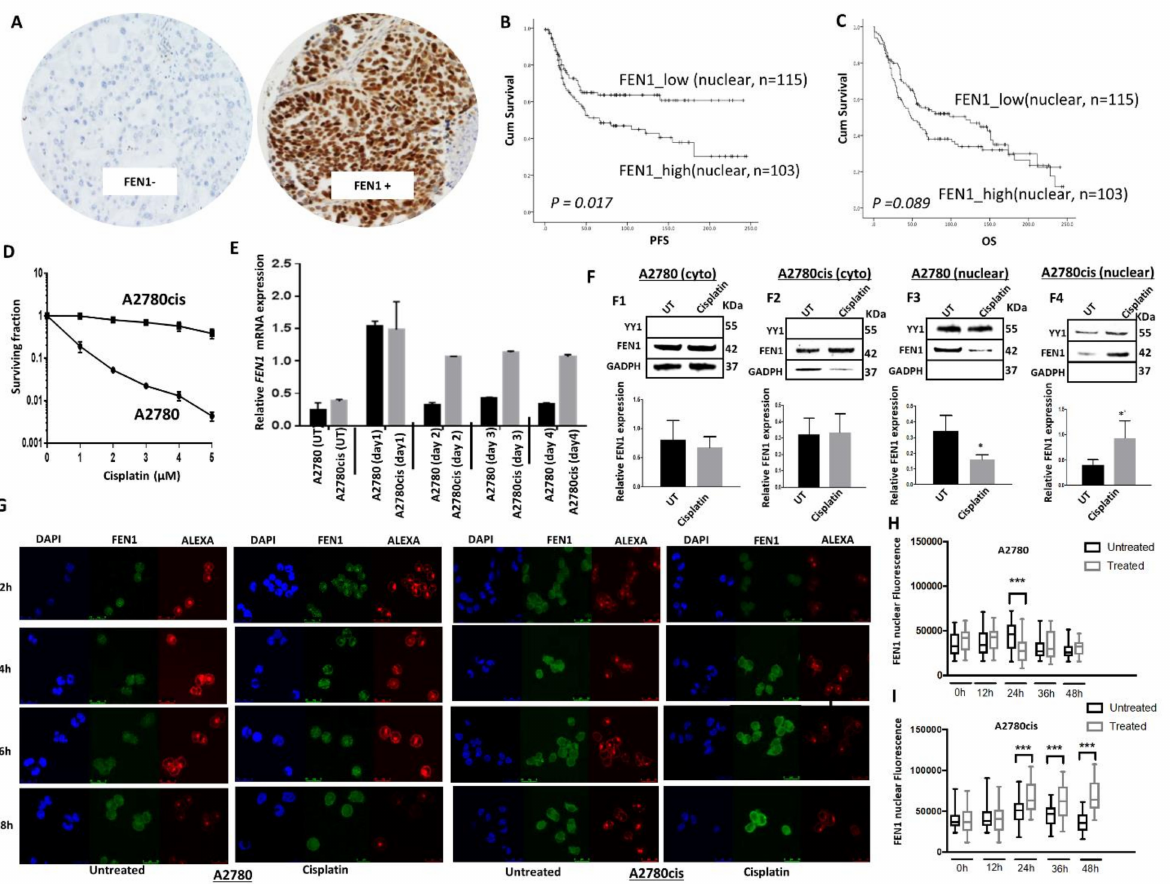
Figure 1. ( A ) Immunohistochemical expression of FEN1 in ovarian cancers. Left side: is ovarian cancer with negative expression (H score 0), right side: is a case with high FEN1 expression (H score 250). ( B ) Kaplan–Meier curve for FEN1 nuclear protein expression and progression-free survival (PFS) in ovarian cancer. ( C ) FEN1 nuclear protein expression and overall survival (OS) in ovarian cancer. ( D ) Clonogenic assay showing cisplatin-sensitive A2780 and cisplatin-resistant A280cis cells ( E ) FEN1 mRNA expression in A2780 and A2780cis cells after cisplatin treatment. ( F ) FEN1 nuclear and cytoplasmic extracts in A2780 and A2780cis treated with 5 µ M cisplatin. Lysates were collected 24 h post-treatment and western blot performed for FEN1 expression. ( G ) Con-focal microscopy showing FEN1 nuclear expression following cisplatin treatment at various time points (12 h, 24 h, 36 h, and 48 h). ( H ) Quantification of FEN1 nuclear fluorescence in A2780 cells. ( I ) Quantification of FEN1 nuclear fluorescence in A2780cis cells. * = p value < 0.05, *** = p value <